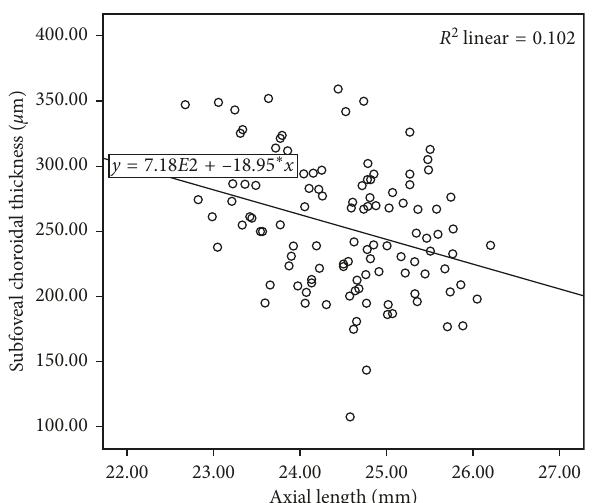
Figure 5: Association between subfoveal choroidal thickness and axial length in the whole